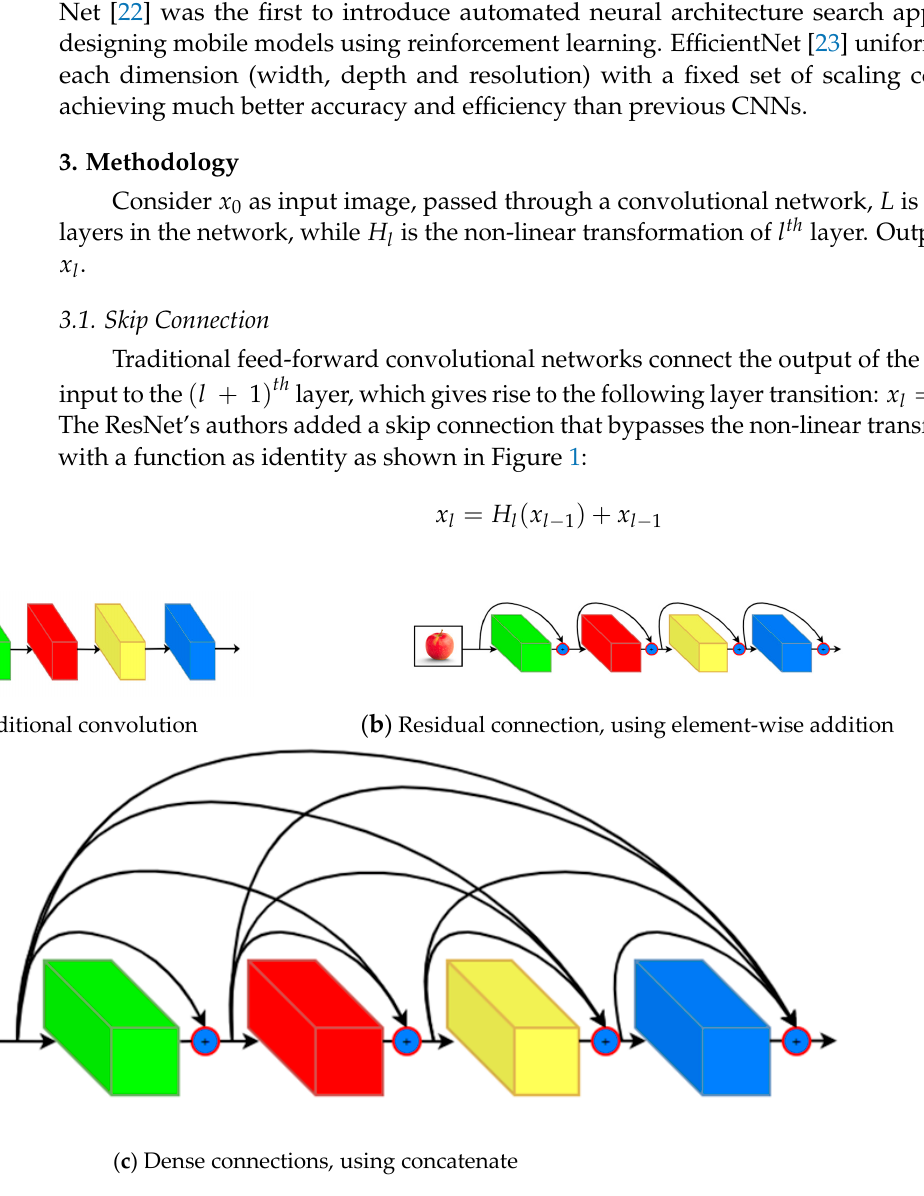
Figure 1. Simple representation of types of convolutions from layer to layer, note that layers have the same height and width.